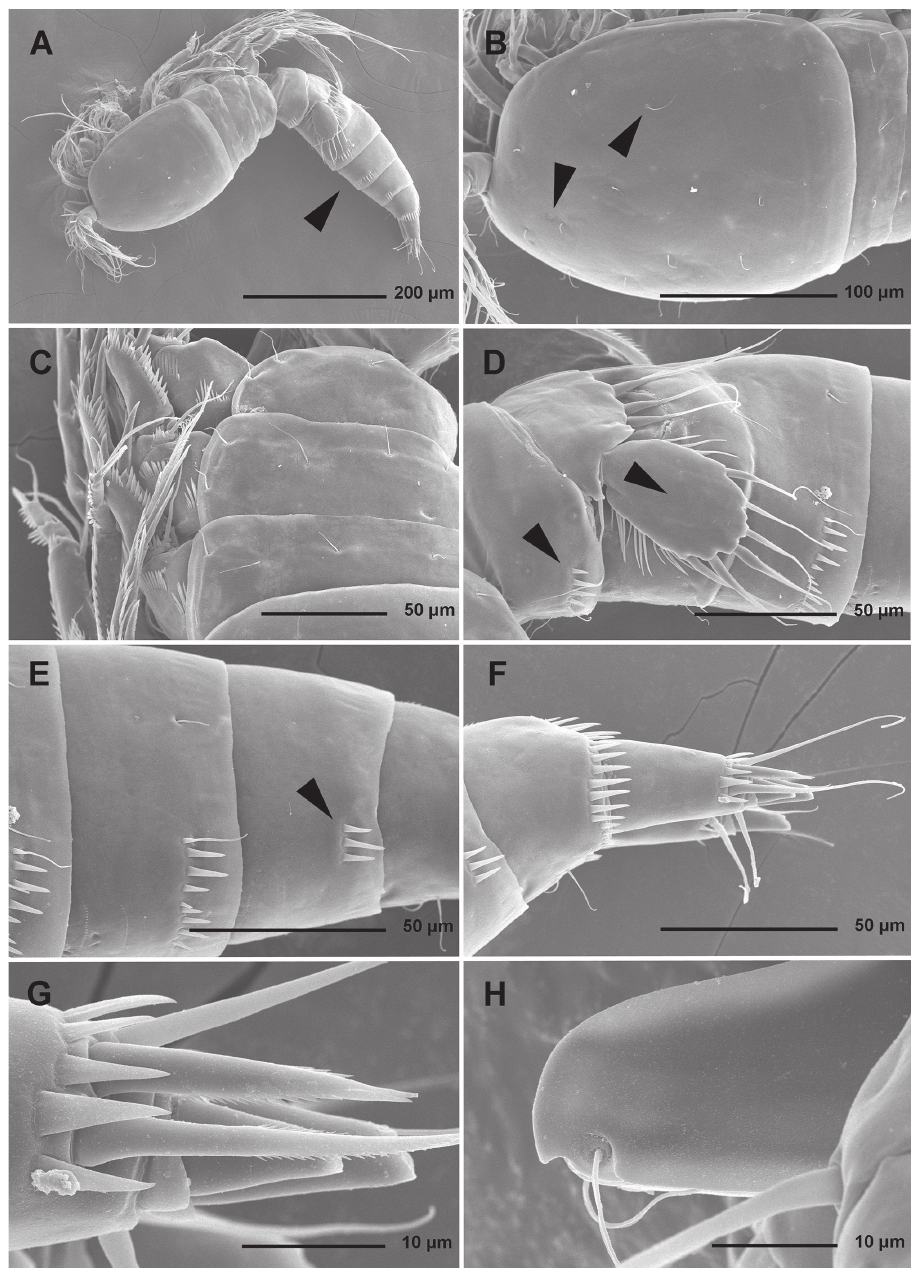
Figure 8. Stenhelia taiae Mu & Huys, 2002, scanning electron micrographs, female: A habitus, lateral B cephalothoracic shield, lateral C free thoracic somites, lateral D fifth pedigerous somite and genital double-somite, lateral E fourth and fifth urosomites, lateral F anal somite and caudal rami, lateral G pos- terior part of right caudal ramus, lateral H rostrum, lateral. Arrowheads indicate morphological characters different from those in S. pubescens Chislenko,